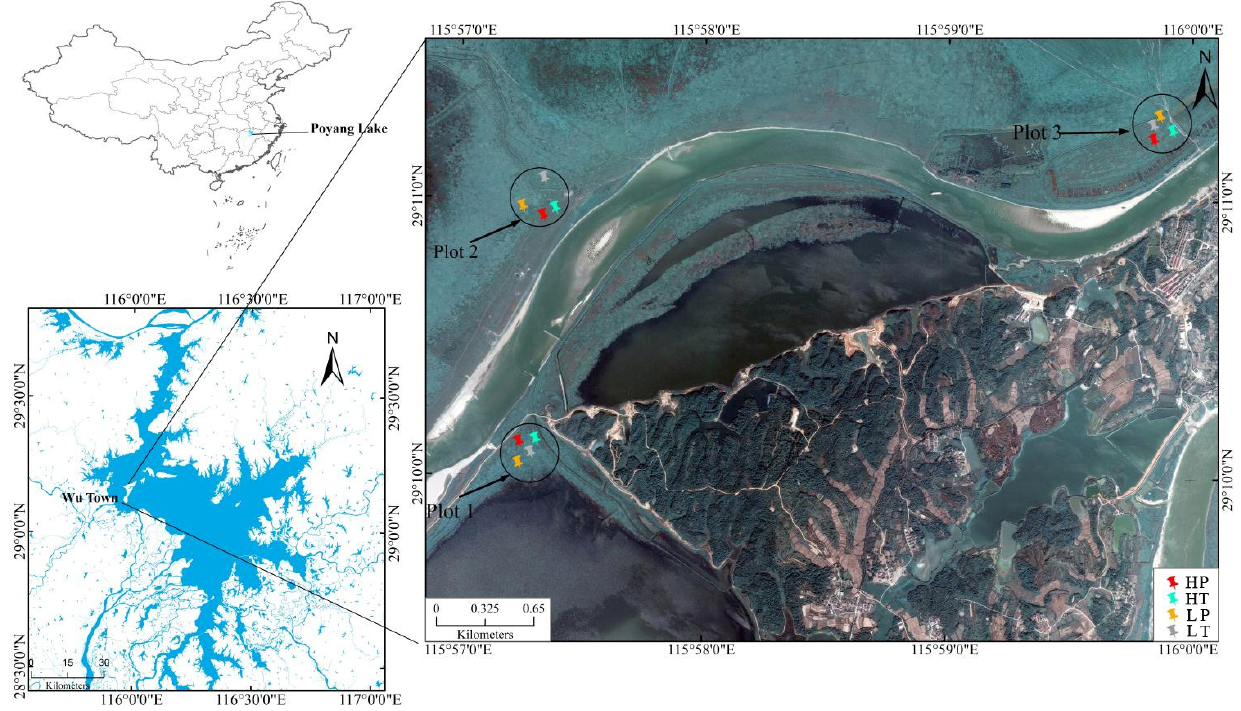
Figure 1. Soil sampling sites in Poyang Lake wetland. HP denotes P. hydropiper community at high level above the water table, HT indicates T. lutarioriparia community at high level above the water table, LP signifies P. hydropiper community at low level above the water table, and LT denotes T. lutarioriparia community at low level above the water table.